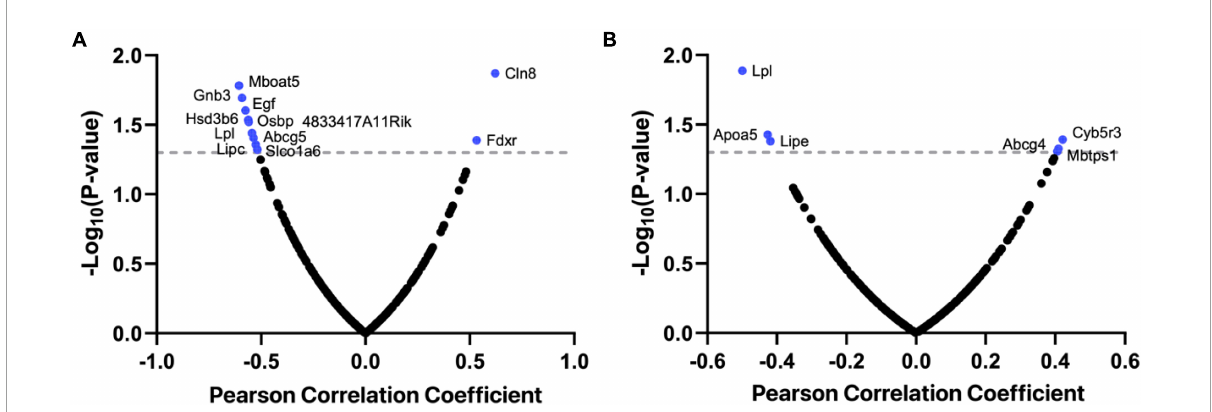
FIGURE1 Bubble charts showing Lpl is a crucial regulator of cognitive function in BXD mice. The mRNA levels of 280 cholesterol-related genes in the BXD hippocampus were correlated against two cognition-related traits, Morris water maze performance (A) and y-maze performance (B) . Pearson correlation coefficient and -log10 p -value are indicated in the x - and y -axis. This analysis was done on the GeneNetwork (https://www.genenetwork.org/).